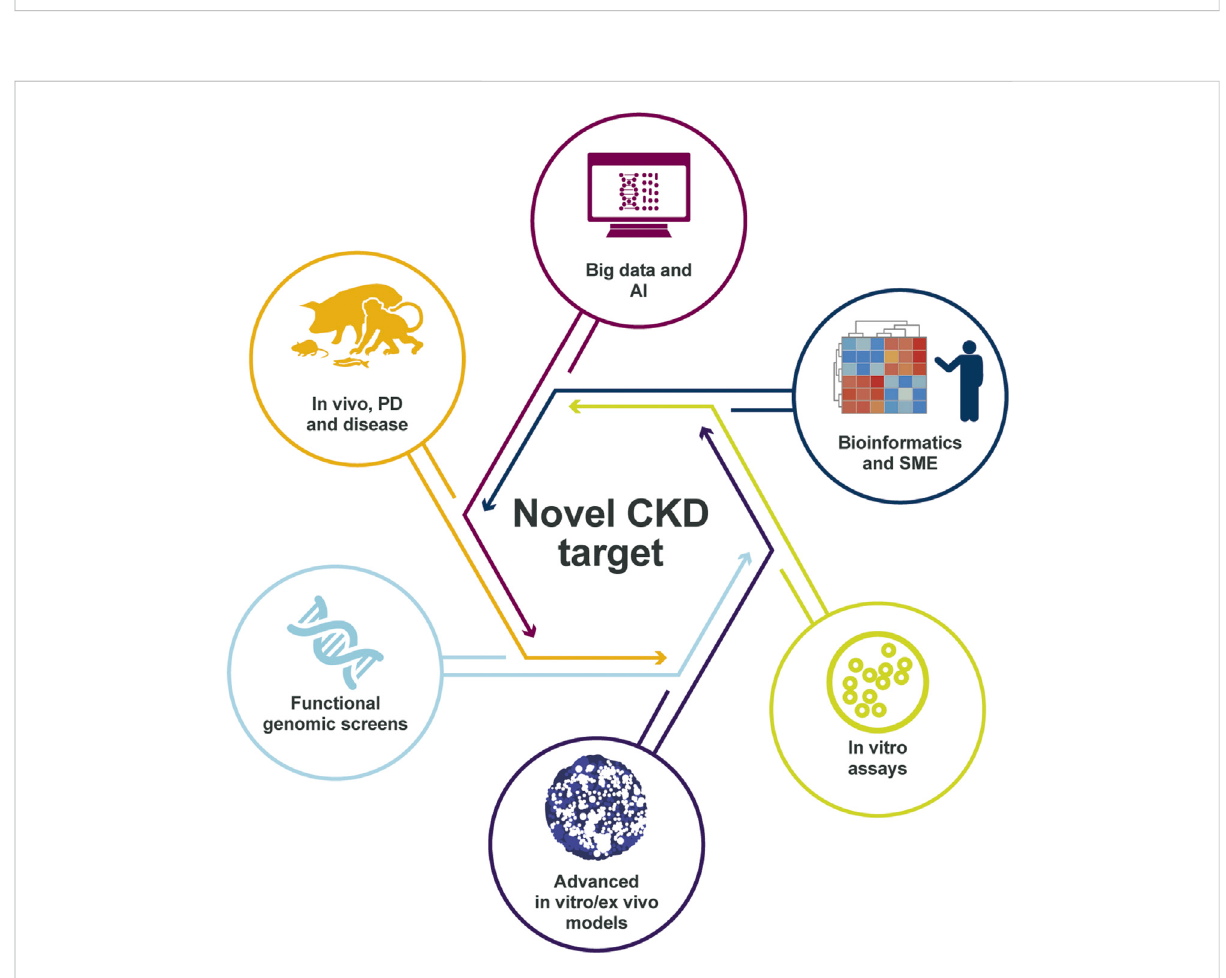
FIGURE 6 Identi fi cation of the right CKD target. The target identi fi cation and validation framework relies on multiple data sources and validation models, integrating many disease-relevant data sets, to create a holistic scienti fi c understanding of the mechanisms that link the target to disease biology. The in-depth scienti fi c understanding of pathophysiology and target link to disease is, in our view, essential for delivering successful medicines to patients with CKD in the future. AI, arti fi cial intelligence; CKD, chronic kidney disease; PD, pharmacodynamics; SME, subject-matter